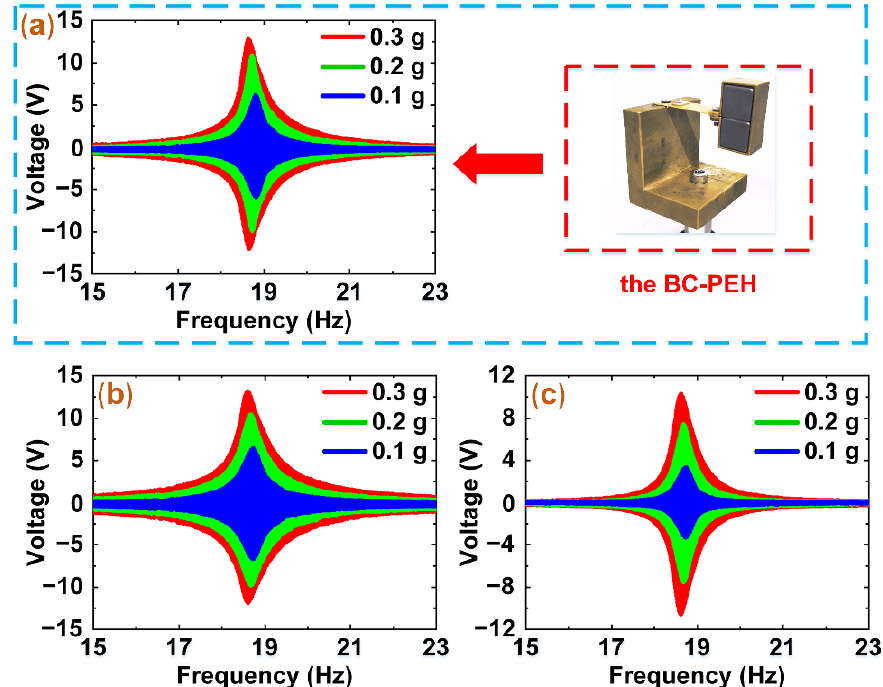
Figure 6. The output voltages of the BC-PEH and the hybrid harvester under different acceleration (0.1 g, 0.2 g, and 0.3 g). ( a ) The output voltages of the BC-PEH. ( b ) The output voltages of the PEH. ( c ) The output voltages of the EMEH.